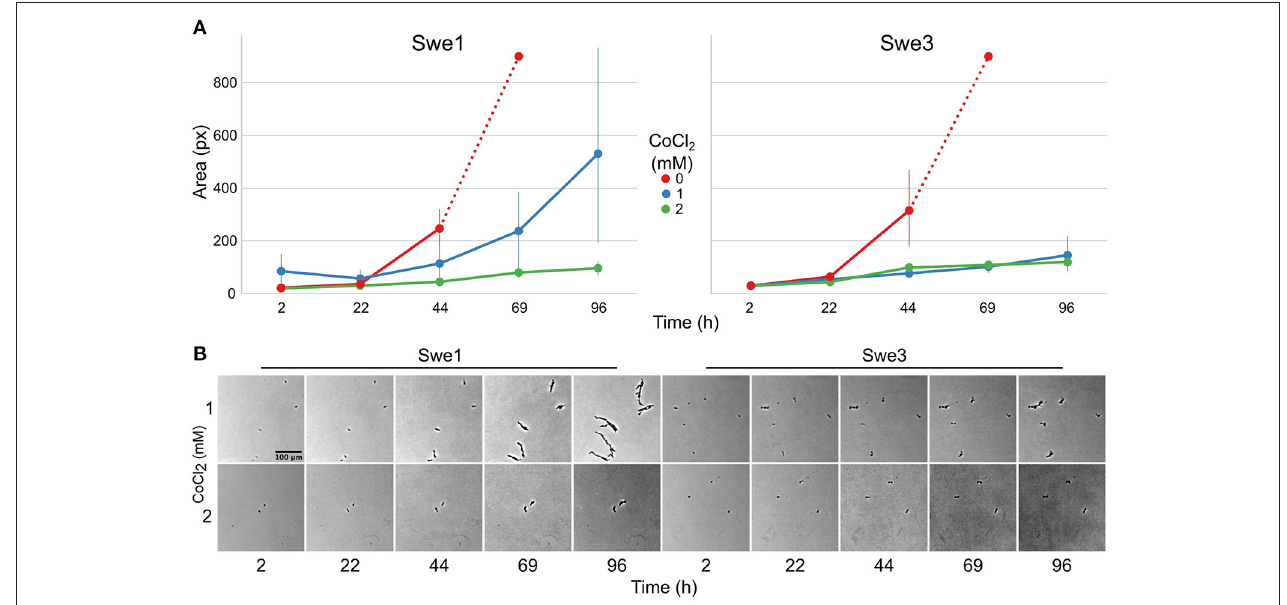
FIGURE 4 | Comparison of the growth of Swe1 and Swe3 in hypoxia-like conditions. (A) Quantification of growth rates for Swe1 and Swe3 on standard NGM plates (0mM), or plates supplemented with CoCl 2 to a final concentration of 1 or 2mM. As illustrated in Figure 1F , measurement beyond 44h of Swe1 and Swe3 growth in the absence of CoCl 2 is confounded by the overgrowth of mycelia derived from separate spores. The average size and 95% confidence interval for 8–35 individual spores per condition, followed at each time point, are shown. (B) Representative images of spores of Swe1 and Swe3 growing in the presence of 1 or 2mM CoCl 2 . A direct comparison can be made with Figure 1F , as the experiments were conducted in